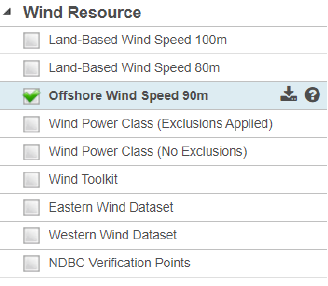
Figure 17. NREL: Available wind parameters. Data source: [124].